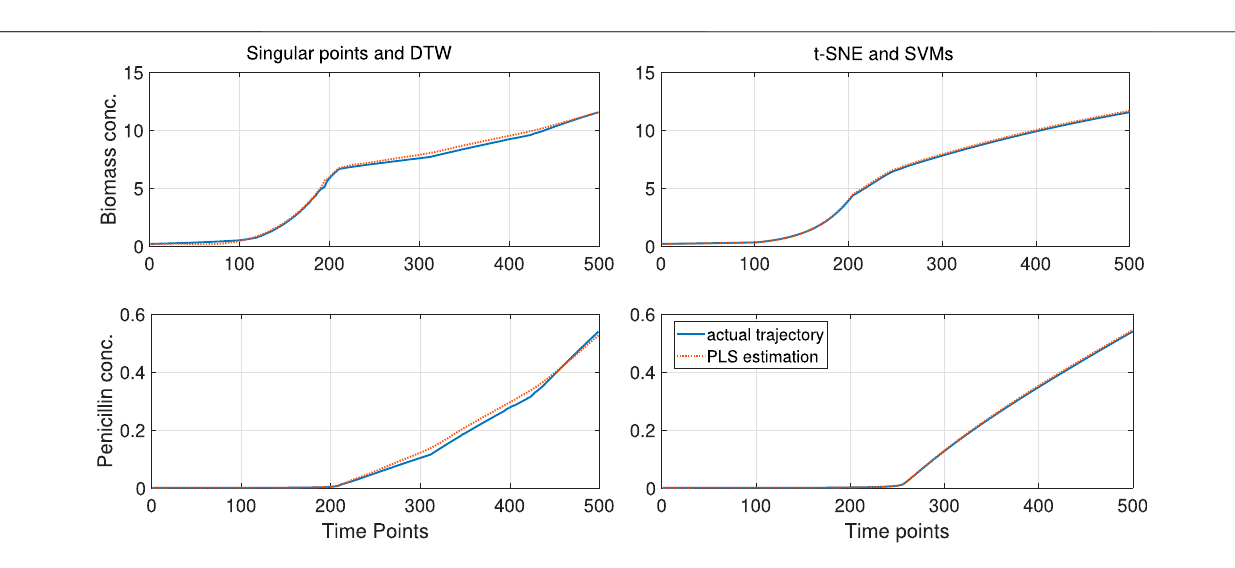
FIGURE 12 | Predicted trajectories for biomass and penicillin concentration based on